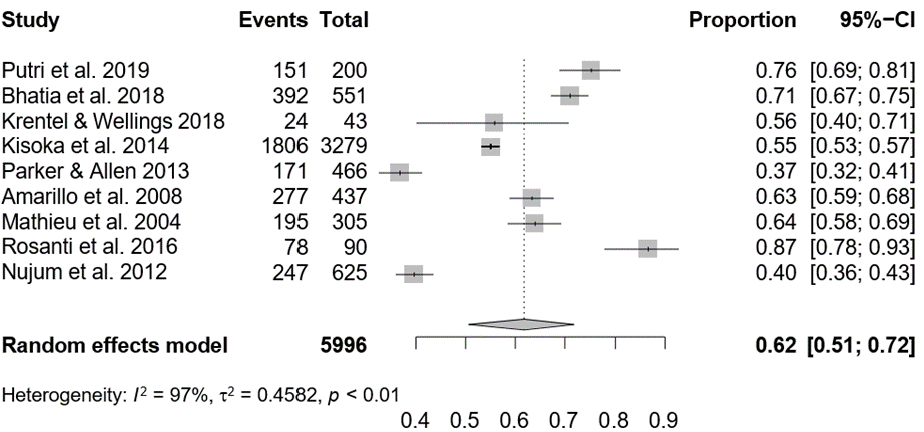
Figure 2. Forest plot of meta-analysis of uptake rate of MDA. (Putri et al. 2019 [22], Bhatia et al. 2018 [23], Krentel & Wellings 2018 [21], Kisoka et al. 2014 [25], Parker & Allen 2013 [26], Amarillo et al. 2008 [27], Mathieu et al. 2004 [28], Rosanti et al. 2016 [20], Nujum et al. 2012 [24]).